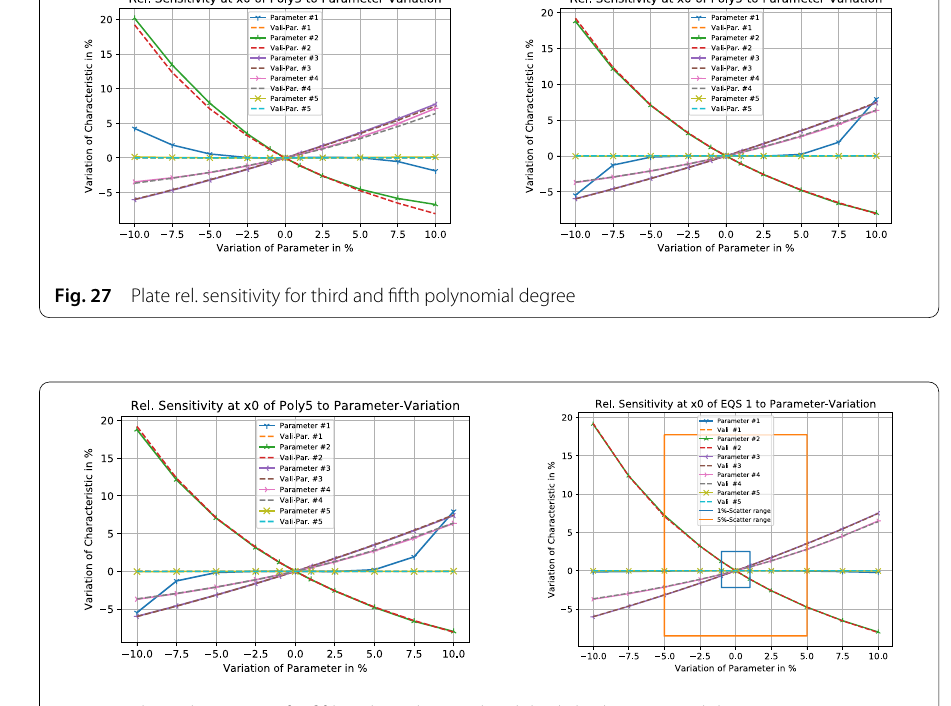
A deeper investigation is done again with the sensitivity study compared to the actual FEA-results. For this case all lines are plotted in one graph and FE-results again are marked by dashed